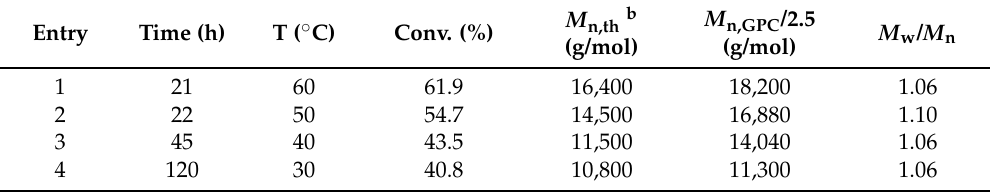
Table 2. Effect of polymerization temperature on initiators for a continuous activator regeneration atom transfer radical polymerization (ICAR ATRP) of AN at ambient pressure a .